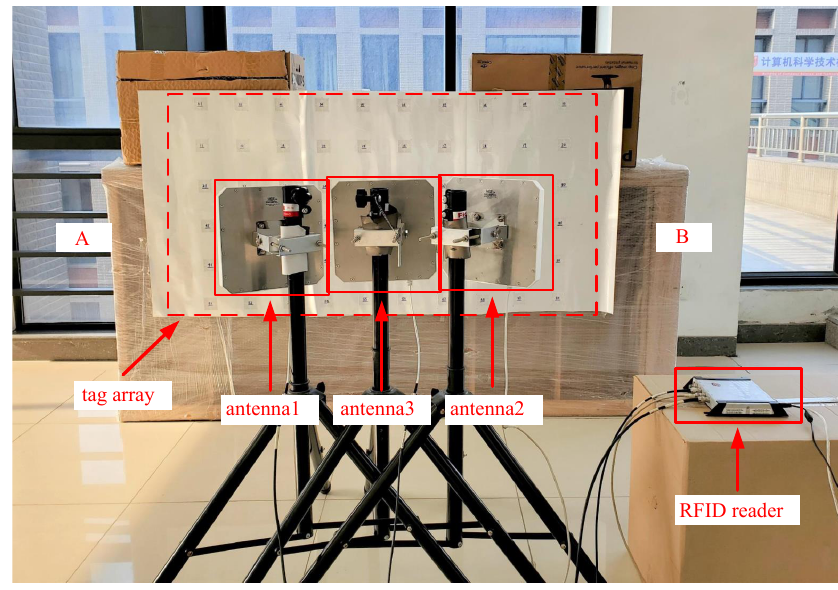
Figure 12. System deployment of